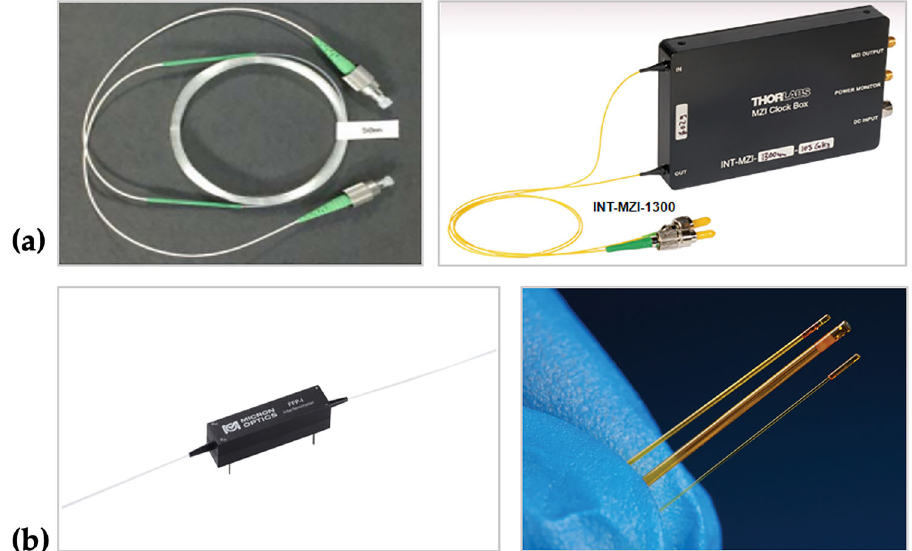
Figure 3. Several commercial optical fiber MZIs [12,13] ( a ) and FPIs [14,15] ( b ).